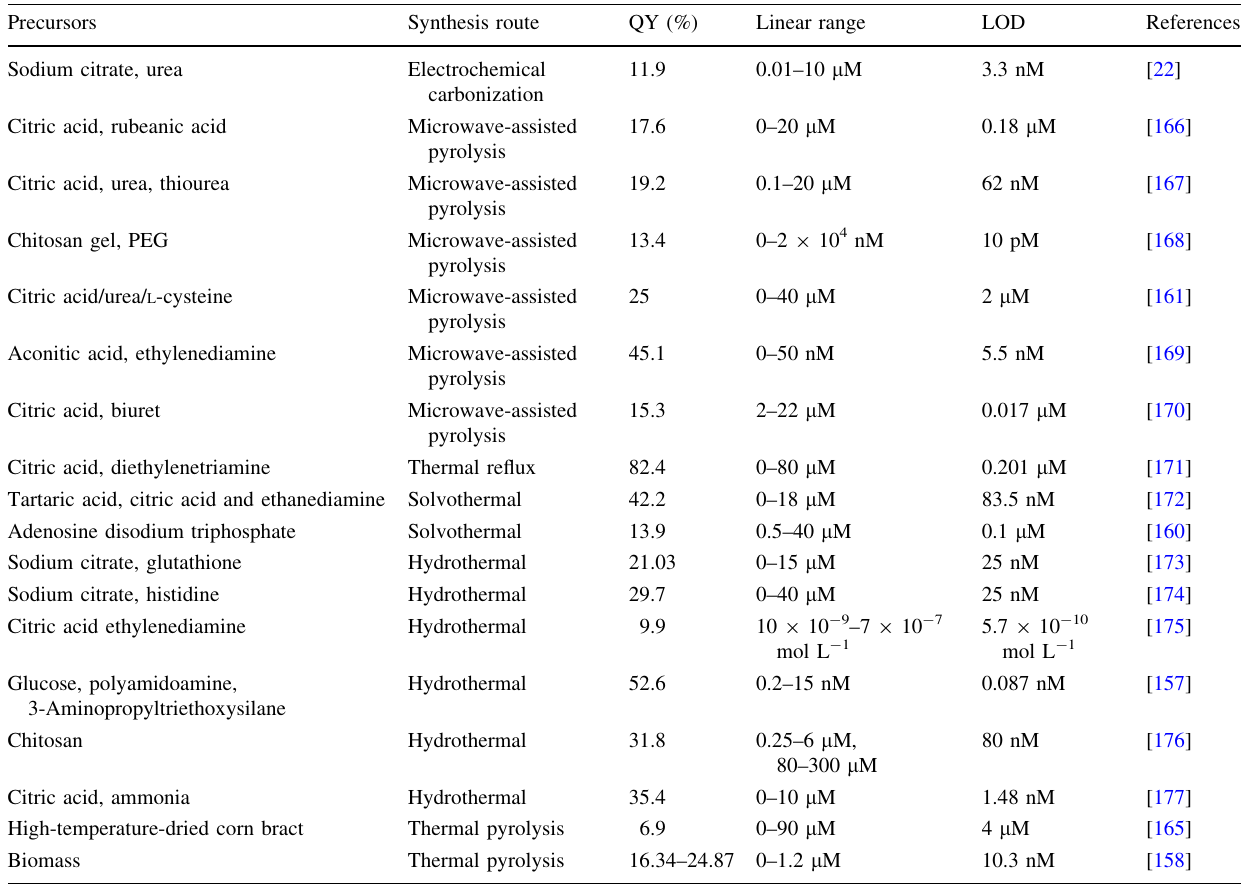
Fig. 17 Schematic illustration of the preparation of dual-emission CDs and their application as ratiometric sensors for Hg 2 ? [165]. Copyright (cid:2) 2017 American Chemical Society Table 4 Recent advances in the preparation of CDs, their corresponding properties, and Hg 2 ? ion sensing performance